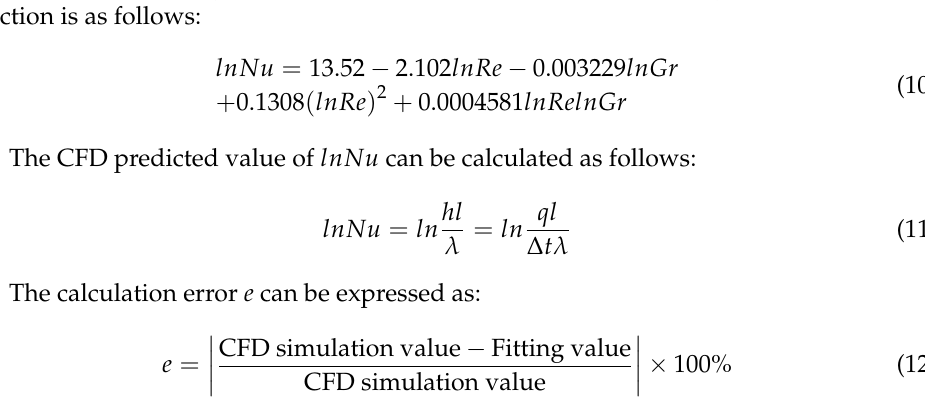
Table 8. Verification results of the fitting